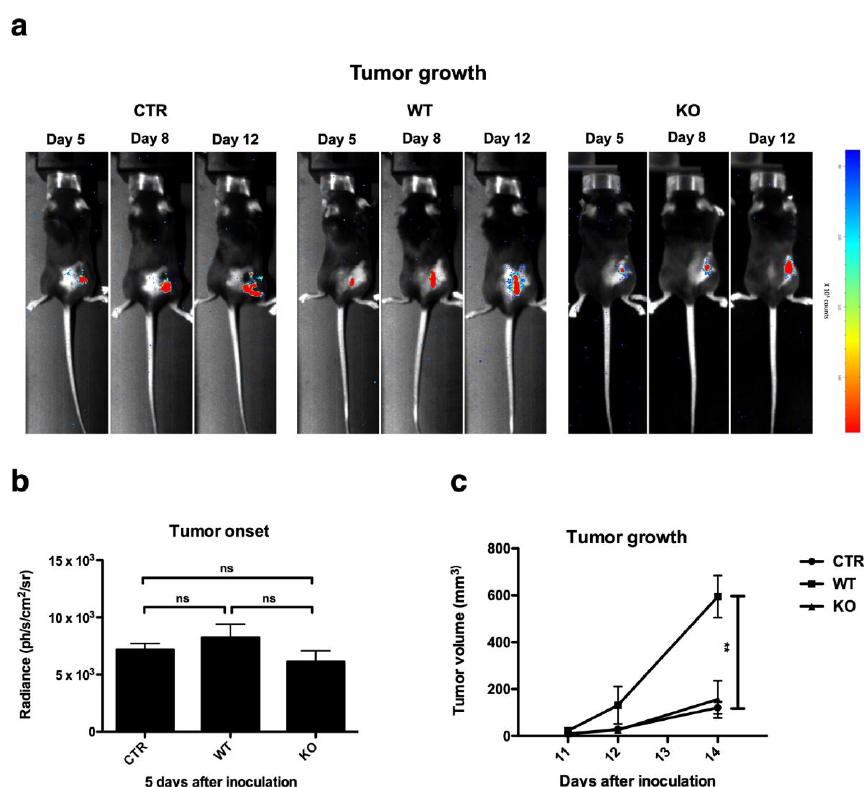
Figure 4. Perforin and GzmB expressing MDSCs promote tumor progression. ( a ) Representative images showing tumor growth of mice inoculated with B16F10-Fluc cells alone, as a control (CTR) or B16F10-Fluc cells co-injected with WT or KO MDSCs, as measured by in vivo bioluminescence imaging. ( b ) Summarizing graph showing onset of tumor growth five days after injection of B16F10-Fluc cells (CTR), or co-injection of B16F10-Fluc cells and WT or KO MDSCs, as measured by in vivo bioluminescence imaging. ( c ) Representative tumor growth curve of mice inoculated with B16F10-Fluc cells alone (CTR) or co-injected with WT or KO MDSCs, as measured by caliper. The graph was shown until day 14, when all tumors in the WT group were resected for further analysis. The mean +/ -SEM of at least six data points is shown in all graphs. All experiments were repeated at least once. A one-way ANOVA was used to calculate statistical significance. Number of asterisks in the figures indicates the level of statistical significance as follows: ns, > 0.05 and **, p <